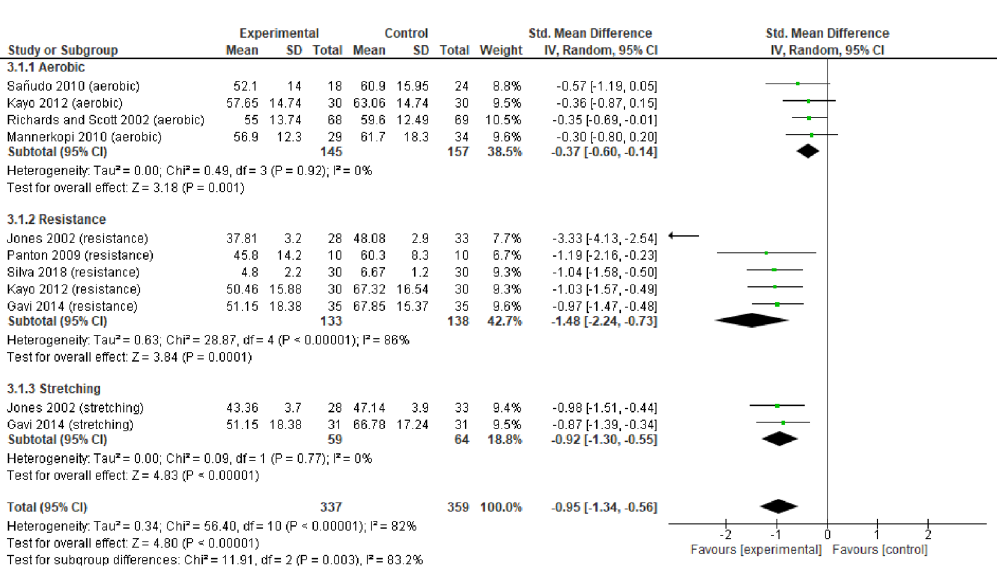
Figure 5. Forest plots showing the effect of training on depression outcomes.